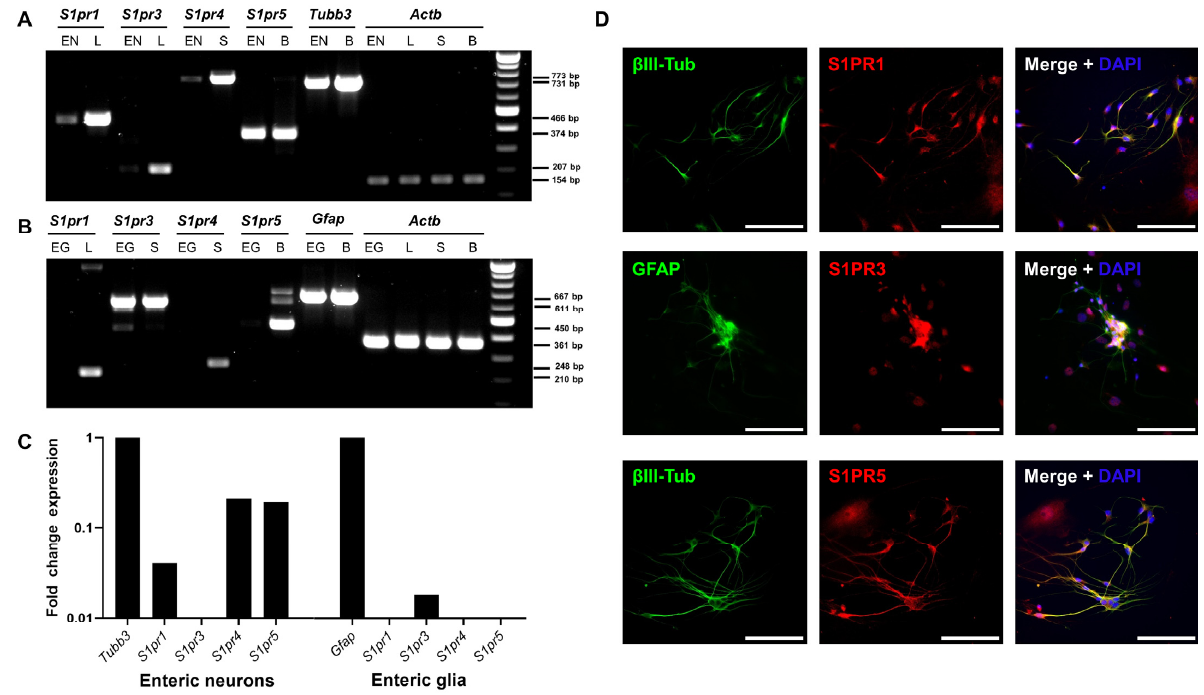
Figure 3. S1pr expression in the enteric nervous system. ( A ) RT-PCR was used to determine mRNA expression of S1P receptors in a murine enteric neuronal cell line (EN). As positive controls, the lung (L) was used for S1pr1 and S1pr3 , the spleen (S) for S1pr4 , and the brain (B) for S1pr5 and Tubb3 , which served as a marker control for neuronal origin genes. ( B ) Expression of S1P receptors was determined in a rat enteric glial cell line (EG). Gfap was used as a control marker gene. ( C ) RT-PCR results were verified by qRT-PCR in EN and rat EG cell lines. Fold change expression was compared with the marker gene expression of Tubb3 and Gfap . ( D ) Murine ENS primary cell cultures were stained for S1PR1, S1PR3 or S1PR5 in combination with the corresponding cell type markers GFAP or β III-tubulin. Scale bars represent 100 µm. S1PR = sphingosine-1-phosphate receptor. EN = enteric neurons, L = lung, S = spleen, B = brain, EG = enteric glial cells, GFAP = glial fibrillary acidic protein, RT-PCR = reverse transcription polymerase chain reaction, qRT-PCR = quantitative real-time poly- merase chain reaction.